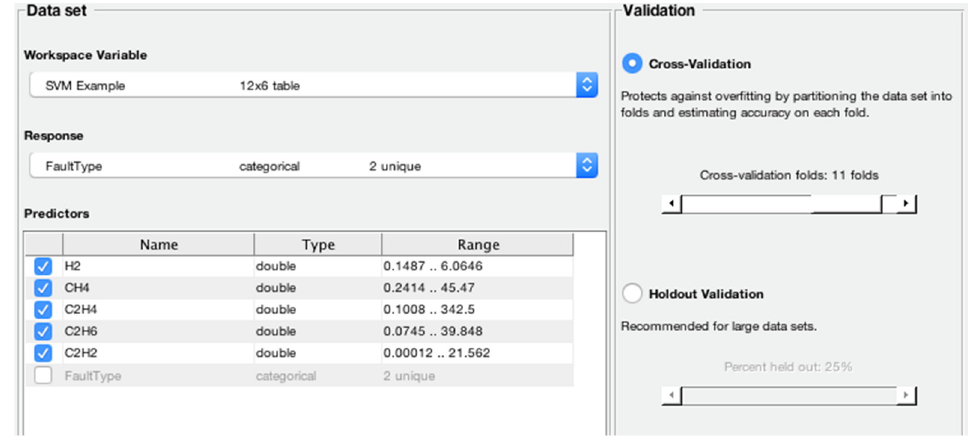
Figure 14. The dataset variables were selected by the SVM 4 classifier. The dissolved gases were automatically placed as the predictors and the fault type as the response. In the SVM 3 algorithm, H 2 and CH 4 were considered to acquire the desired output. The characterization of H 2 versus CH 4 is illustrated in Figure 15.